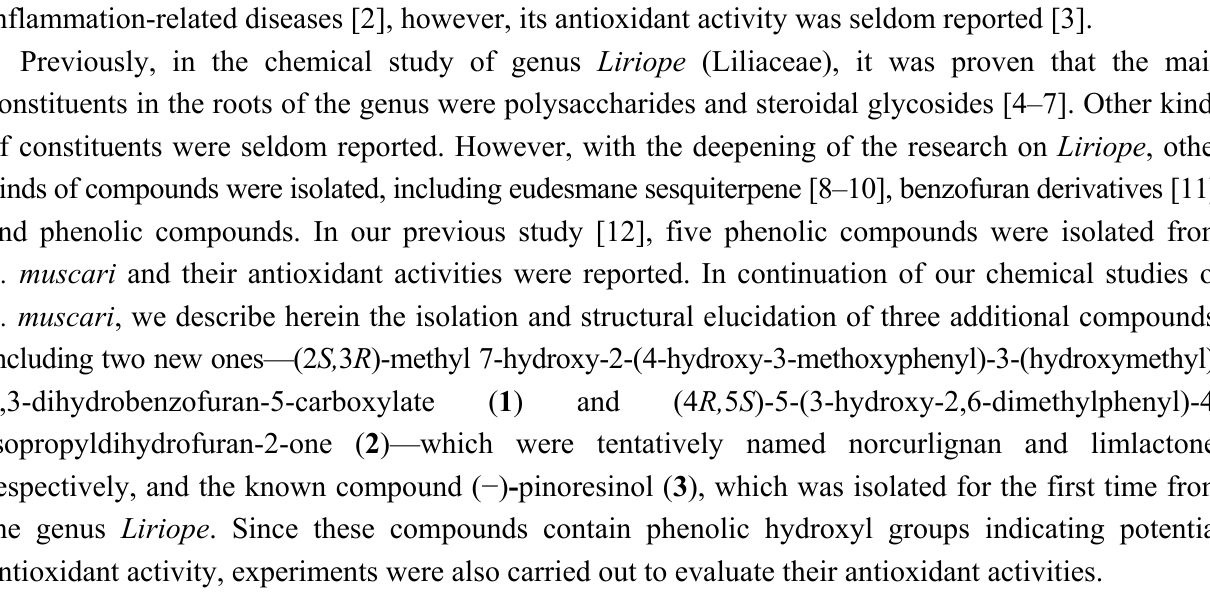
Figure 1. Structures of compounds isolated from L. muscari